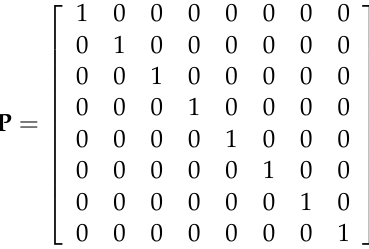
ing mode control law and the nonlinear H ∞ control law. mode control law and the nonlinear H